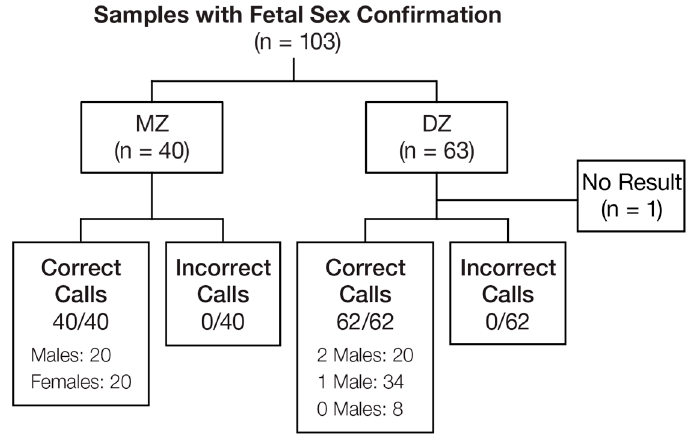
Figure 4. Fetal sex determination. MZ—monozygotic; DZ—dizygotic.